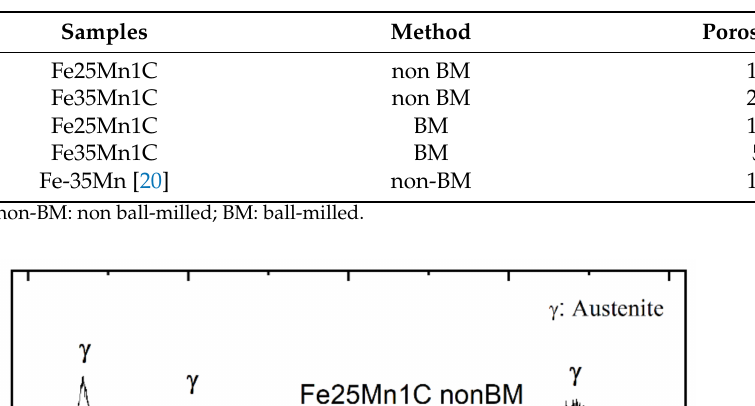
Table 2. Mixing method of the sample powders and their porosity.